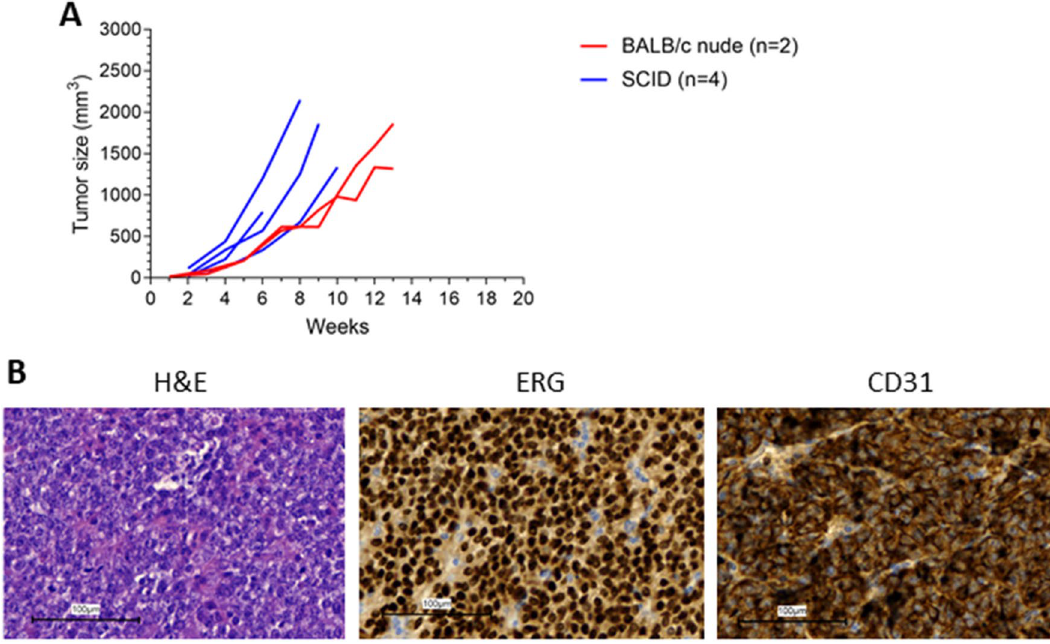
Figure 5. Growth in BALB/c nude mice. ( A ) Growth curves of PDX passage 5 in SCID mice versus BALB/c nude mice. Each line represents a separate tumor. ( B ) H&E, ERG and CD31 staining on PDX material implanted in BALB/c nude